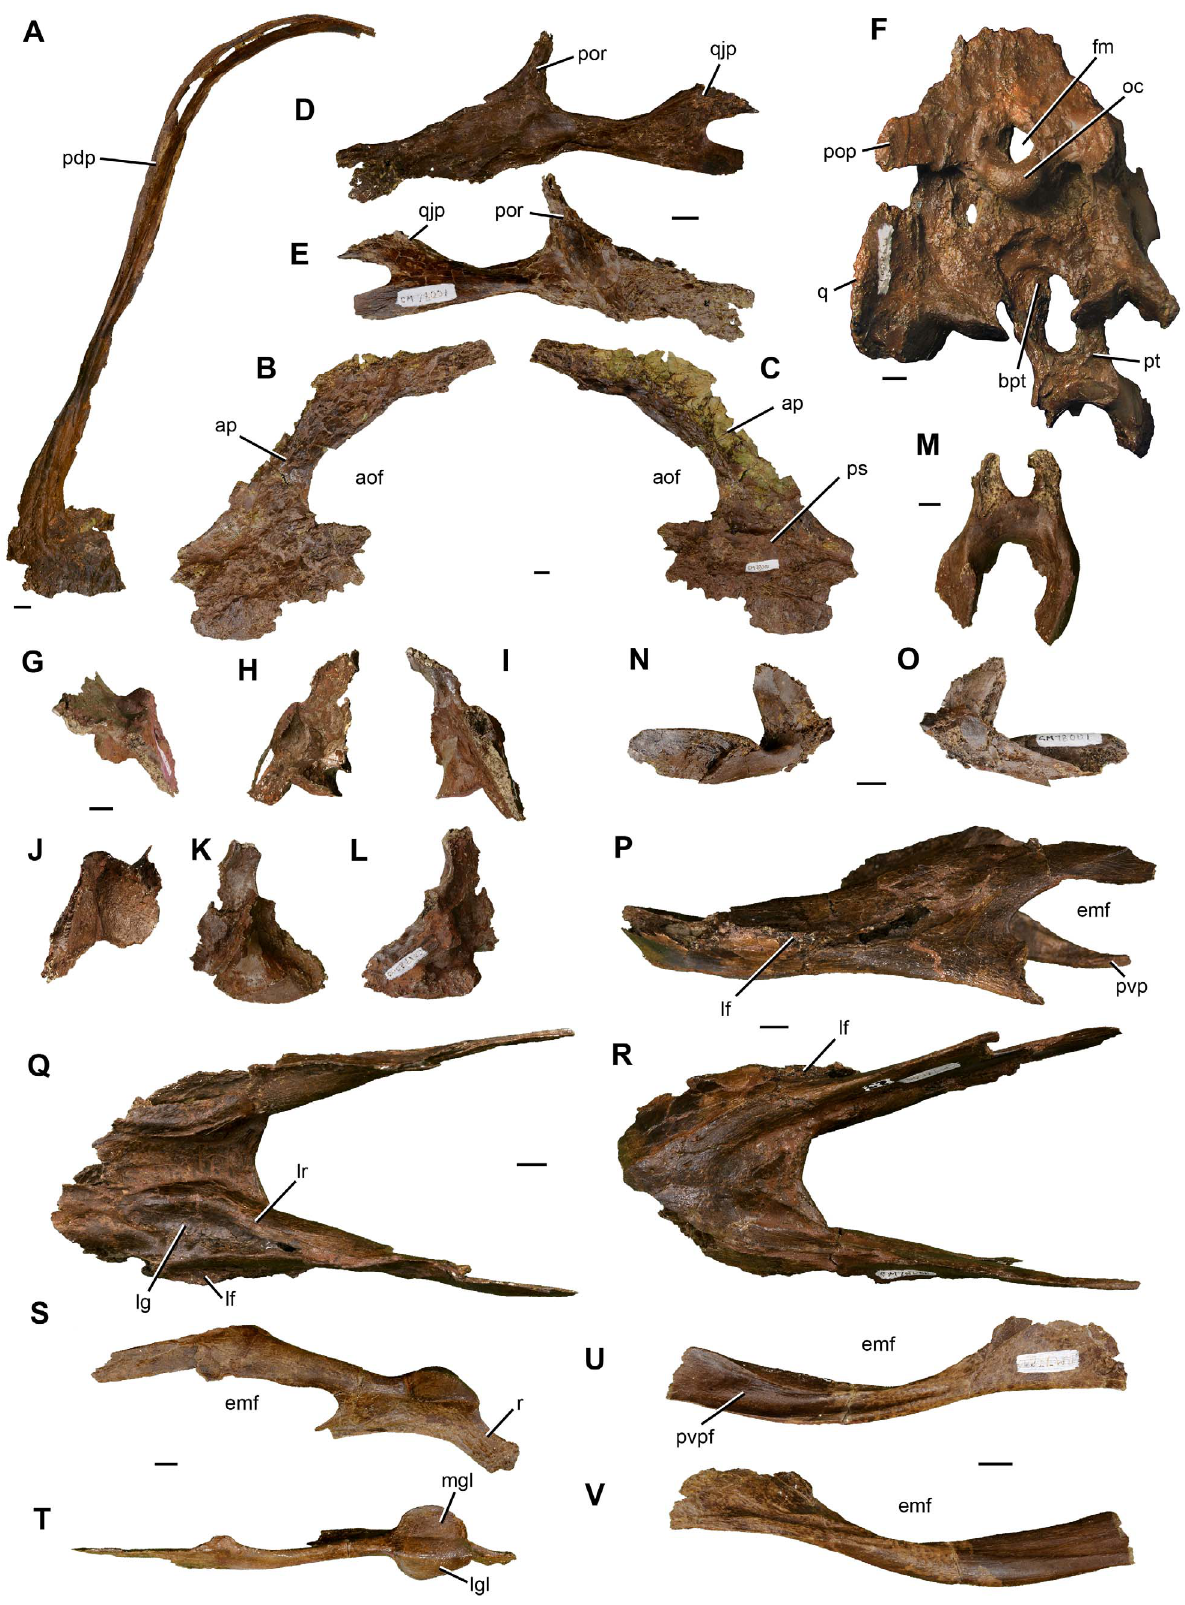
Figure 3. Photographs of craniomandibular elements of Anzuwyliei gen. et sp. nov. ( A ) Left premaxilla of CM 78001 in lateral view. Left maxilla of CM 78001 in lateral ( B ) and medial ( C ) views. Left jugal of CM 78001 in lateral ( D ) and medial ( E ) views. ( F ) Braincase with articulated